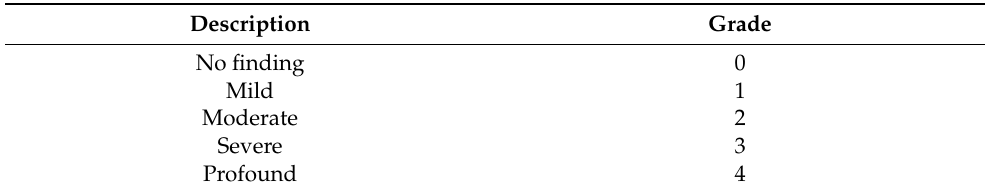
Table A6. MRI score scale for post-harvest evaluation and scoring of subchondral bone sclerosis and bone marrow edema in caprine